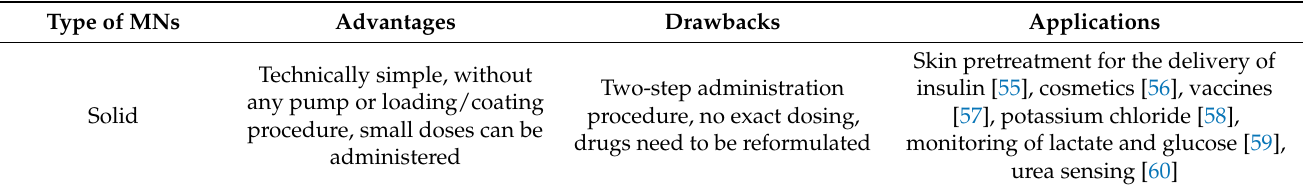
Table 1. Advantages, disadvantages, and applications used for different types of microneedles (MNs). Type of MNs Advantages Drawbacks